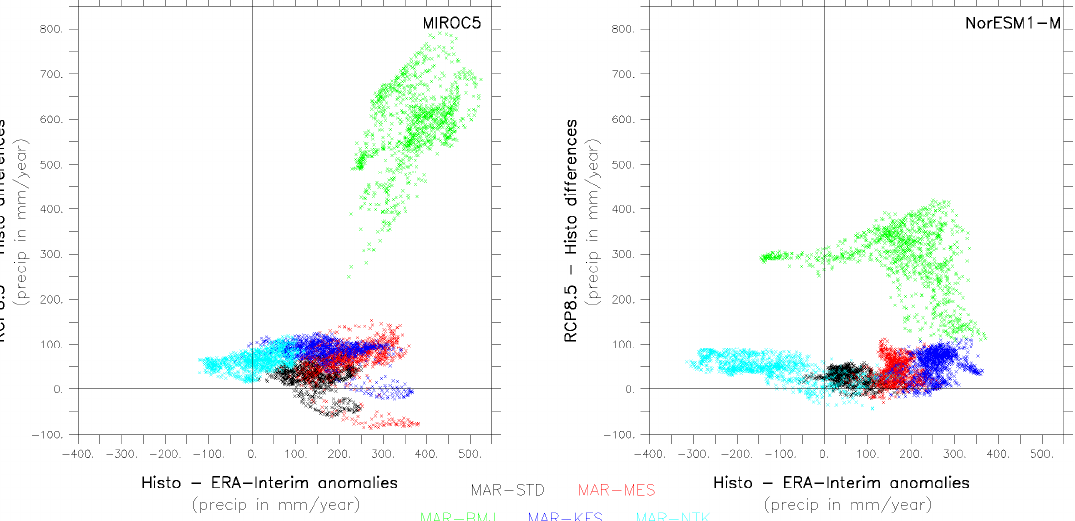
Figure 6. Mean present anomalies (Histo-ERA-Interim) of annual precipitation (mm/year) versus future differences (RCP8.5-Histo) of annual precipitation (mm/year) for each pixel of the Belgian domain of MAR forced by the GCMs MIROC5 (left) and NorESM1-M (right). Each color represents the MAR version depending on the convection scheme used. “Histo” and “ERA-Interim” correspond to the present-day simulation period (1987-2017) when MAR is forced by both GCMs based Historical scenarios or by the ERA-Interim reanalysis.